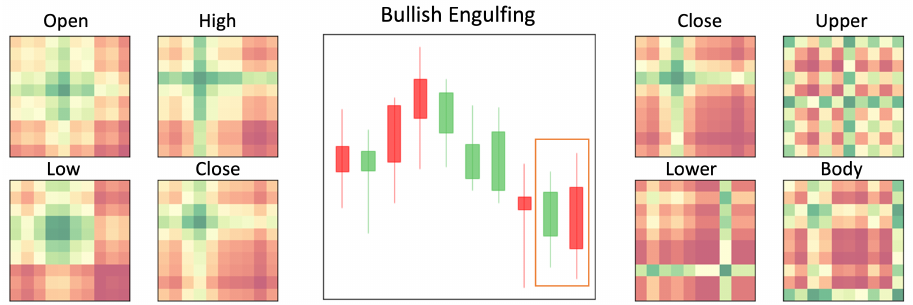
Figure 15. Example of Bullish Engulfing pattern and GASFs. The middlemost figure is the original candlesticks. The red and green candlesticks represent closing prices are higher than the opening prices are not. The left and right sides are the heatmaps of GASFs. The range of the heatmap is ( − 1,1 ) , where red equals − 1 and green equals 1.